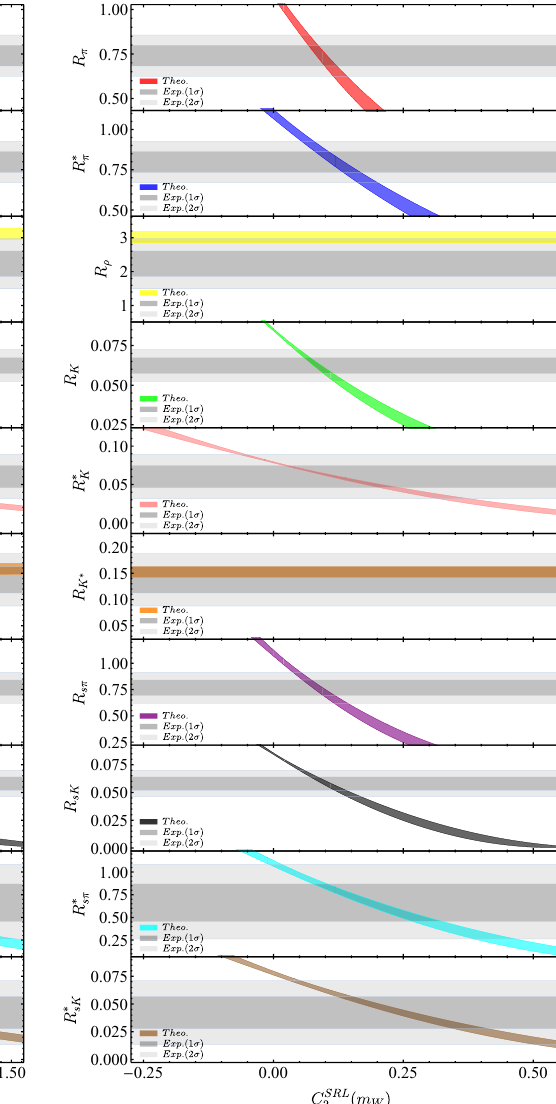
( m W ) (left) and C SRL ( m W ) 1 2